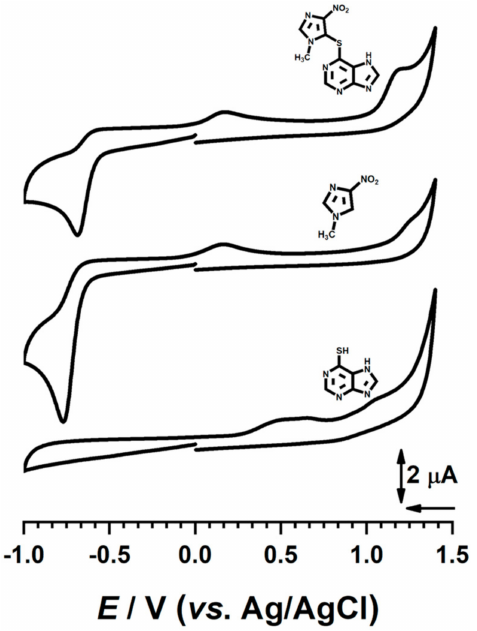
Figure 4. Cyclic voltammograms in 500 µ M azathioprine (Aza), 4 methyl-1-nitro-imidazole (Imi), and 6-mercaptopurine (Merc) in acetate buffer (0.1 M, pH = 7, v = 100 mV s − 1